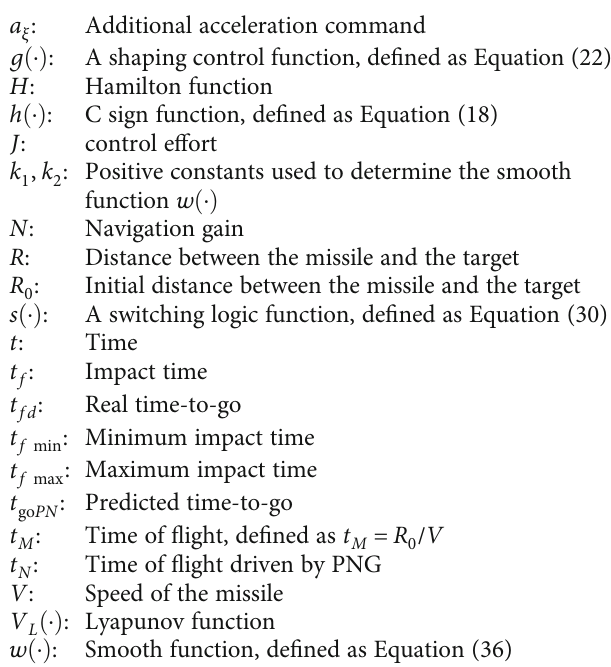
= 0 deg ; t = 39 s f 0